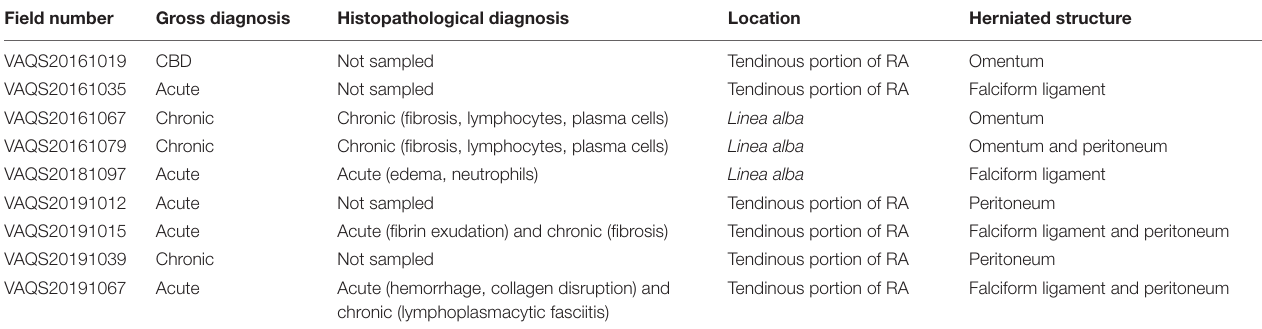
TABLE 2 | Hernia chronicity determined by gross diagnosis and histopathological diagnosis, location of hernia, and herniated structure(s). Field number Gross diagnosis